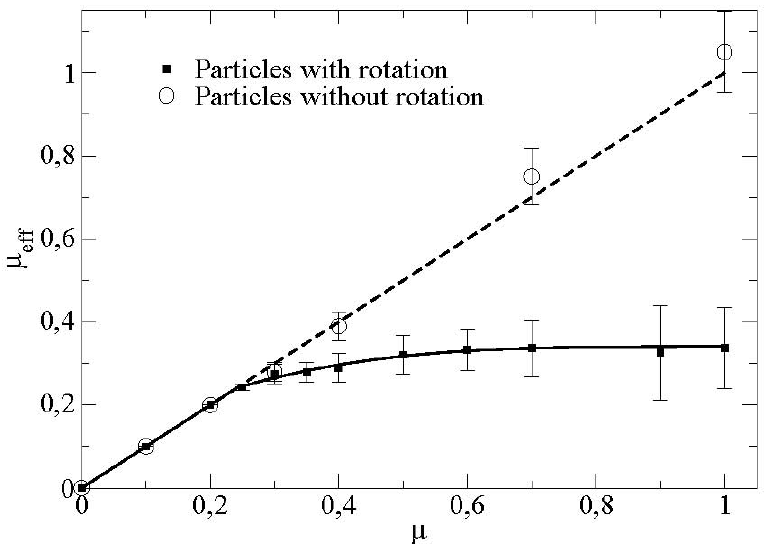
Figure 8. Mean effective friction at the boundary as a function of the friction coefficient particle/vane for particles with and without rotational degrees of freedom ( μ ’ =